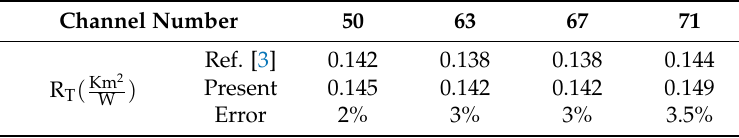
Table 2. The differences between the present model and that of